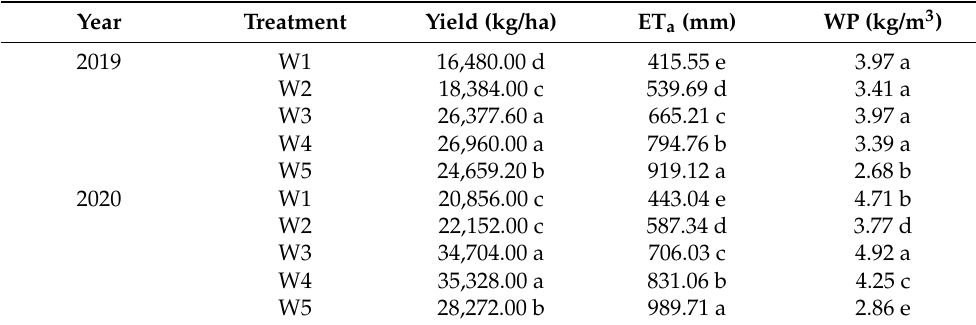
Table 6. Apple yield, crop evapotranspiration (ET a ) and water productivity (WP) of the five irrigation treatments in 2019 and